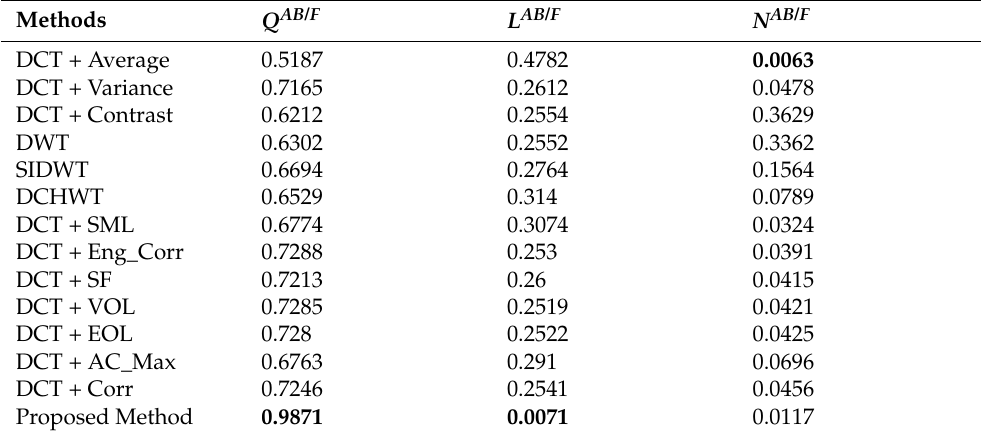
Table 13. The outcomes for the desk image and comparisons with existing techniques in the literature ([26]).